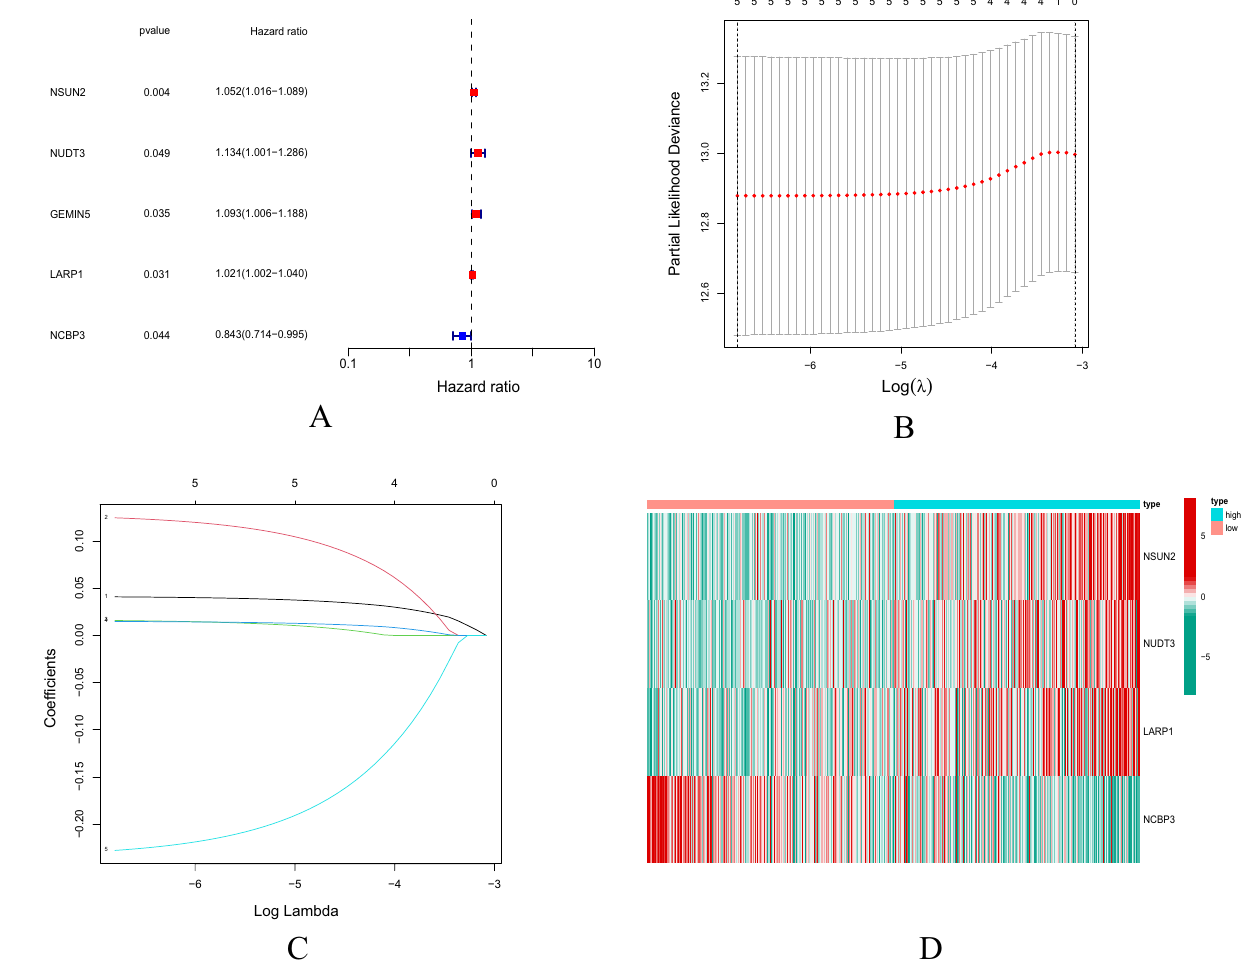
Figure 3. Construction of m7G-related mRNA prognostic model. ( A ) Screening prognostic mRNAs using univariate COX regression analysis. ( B ) LASSO regression analysis. ( C ) Multivariate COX proportional risk regression analysis of four prognostic mRNAs for establishment of a prognostic model. ( D ) Heatmap of prognostic-related m7G-related mRNAs. Green represents low expression of m7G-related mRNA, red represents highexpression of m7G-related